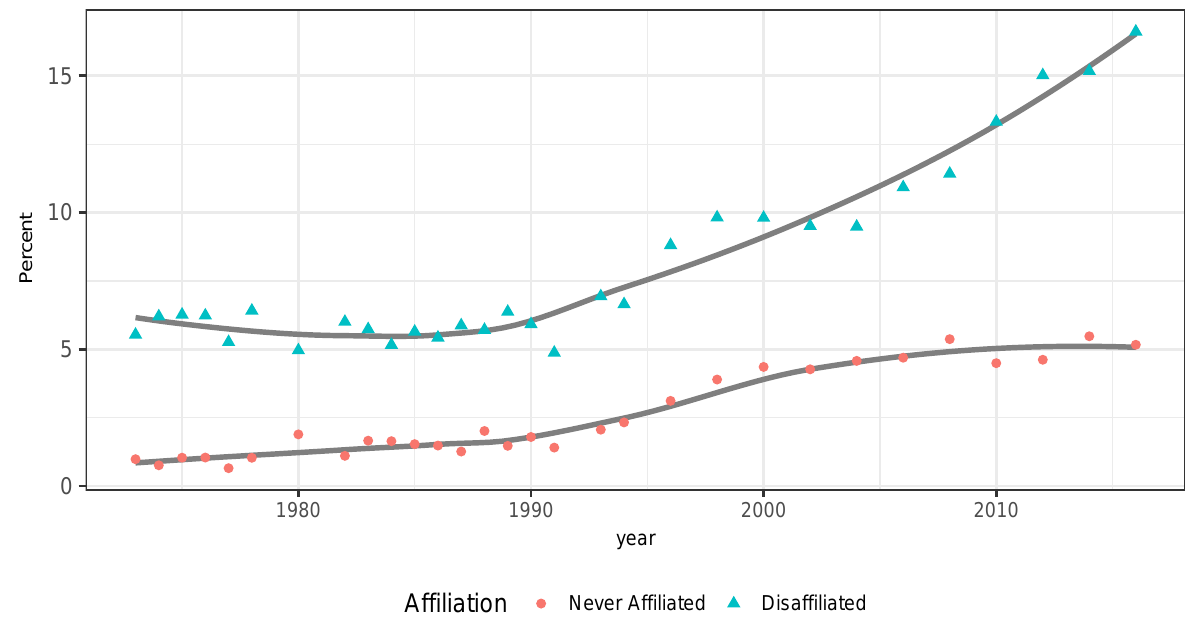
Figure 5: Percentage of respondents in the General Social Survey who dissafiliated from religion and who were never affiliated with religion by year. Smoothed trends are shown in grey. All percentages are sample